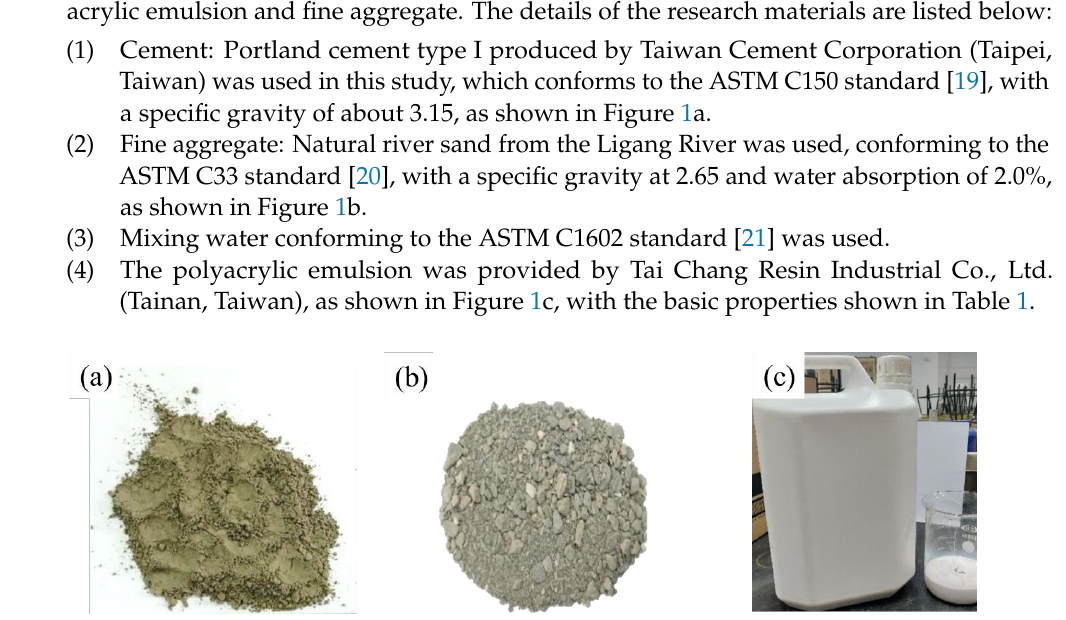
Figure 1. Materials: ( a ) cement, ( b ) fine aggregate, and ( c ) polyacrylic emulsion. Table 1. Physical and chemical properties of the polyacrylic emulsion. Physical Properties